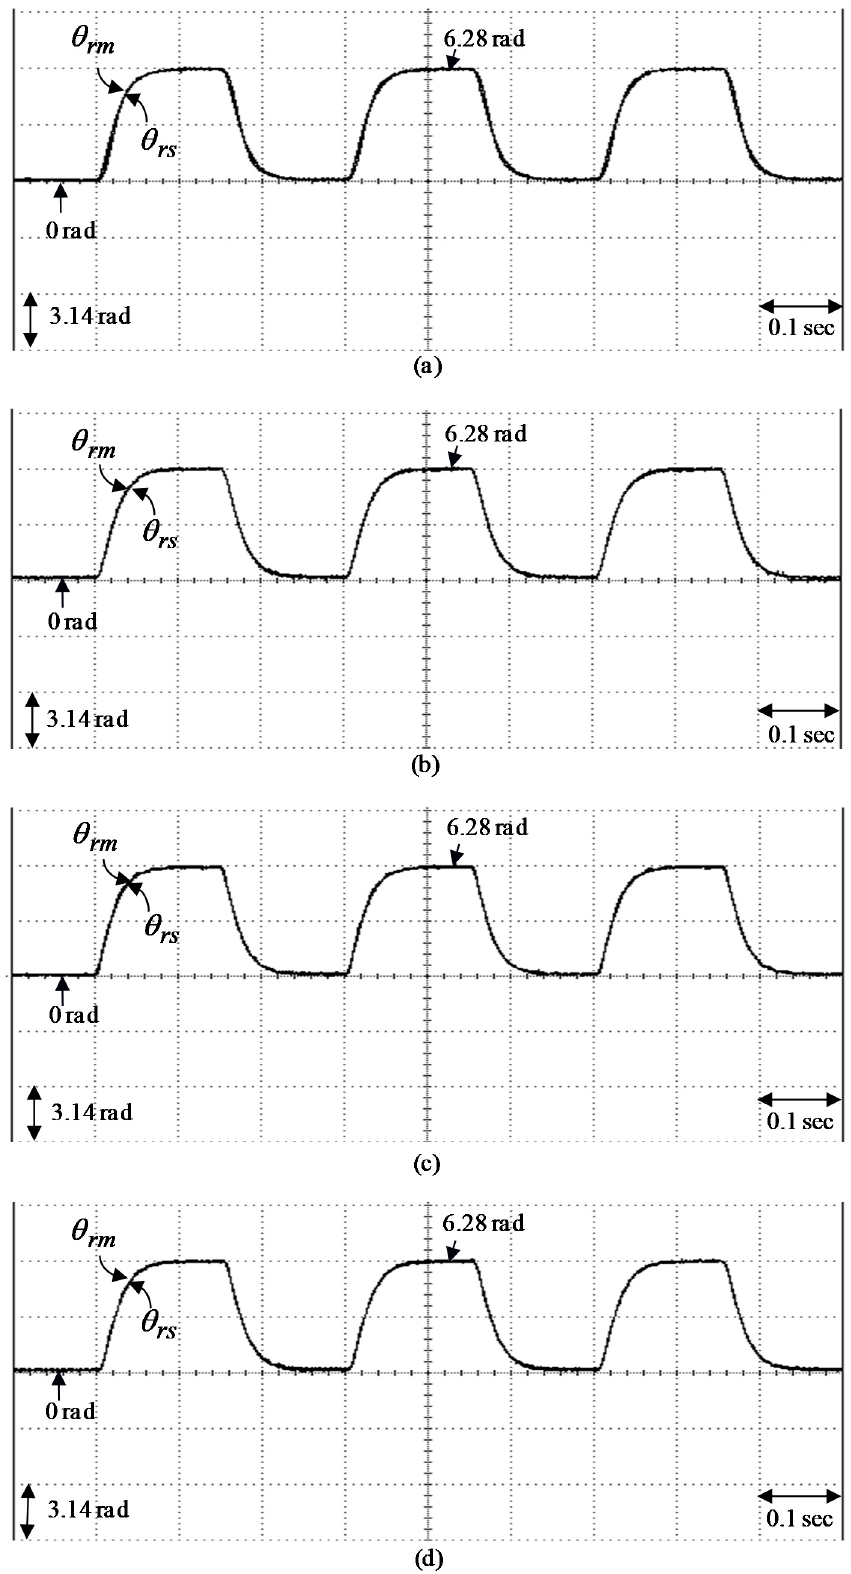
Figure 10. Experimental results of the rotor position response in Case R2 ( a ) by utilizing control system W1, ( b ) W2, ( c ) W3, and ( d ) W4.